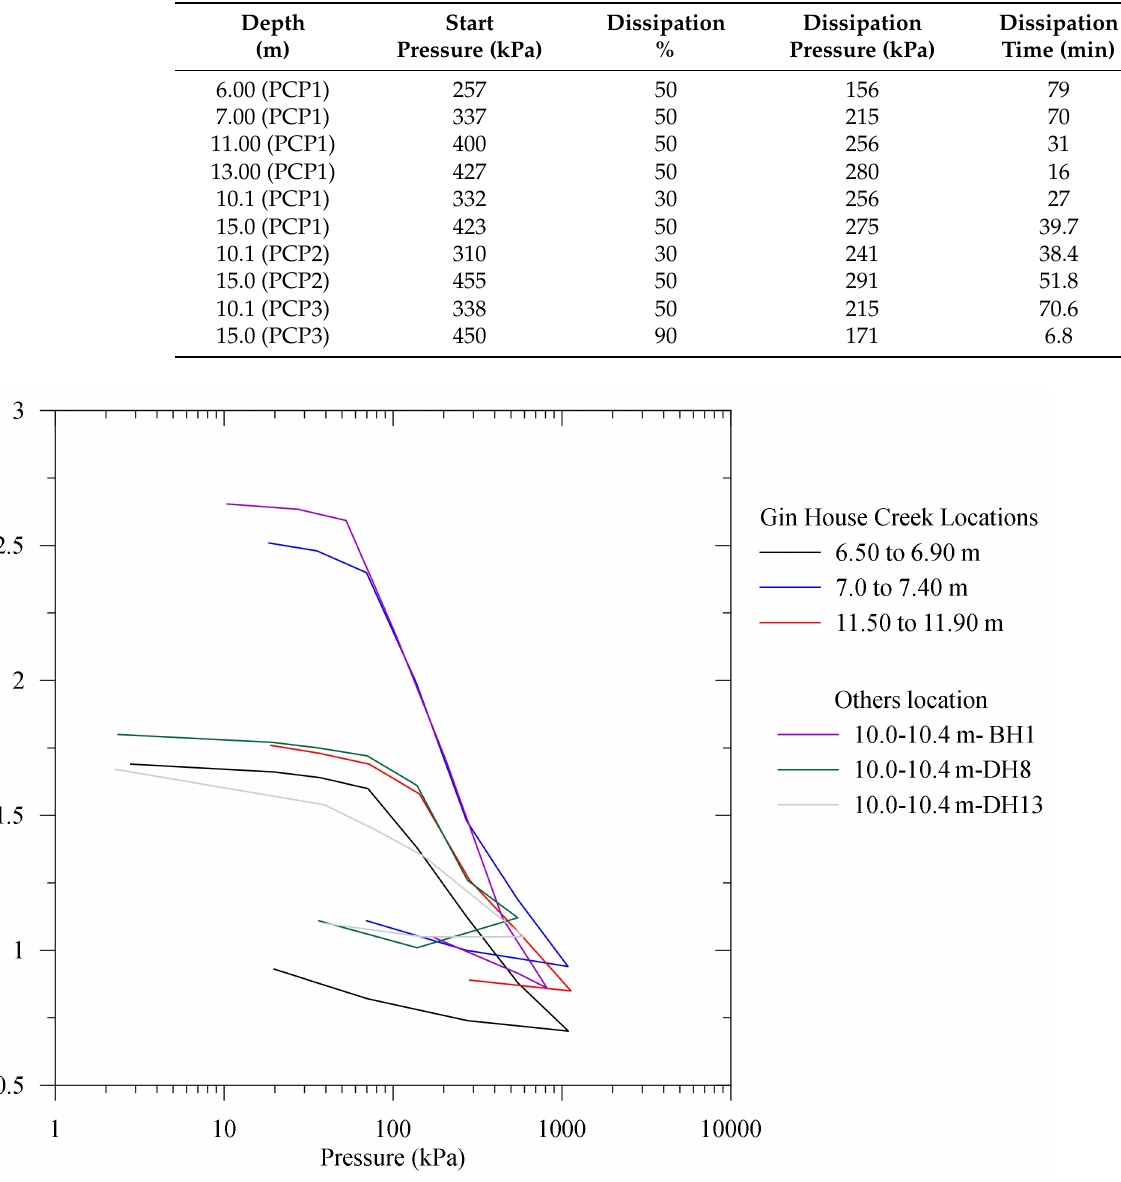
Table 1. The NBR embankment’s Piezocone dissipation data.